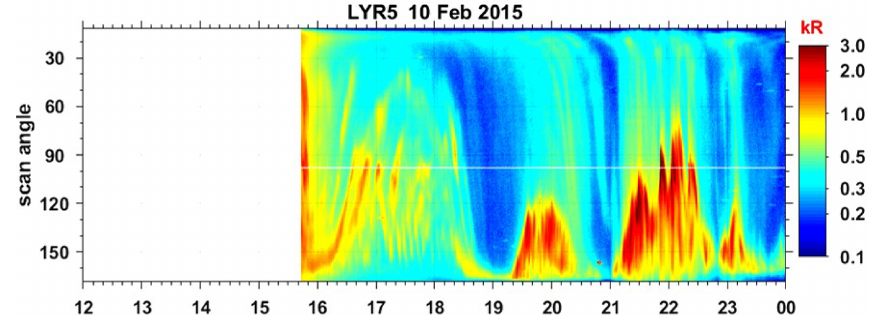
Figure 8. Keogram (630.0nm emission line) from the all-sky imager at LYR station for 10 February 2015.